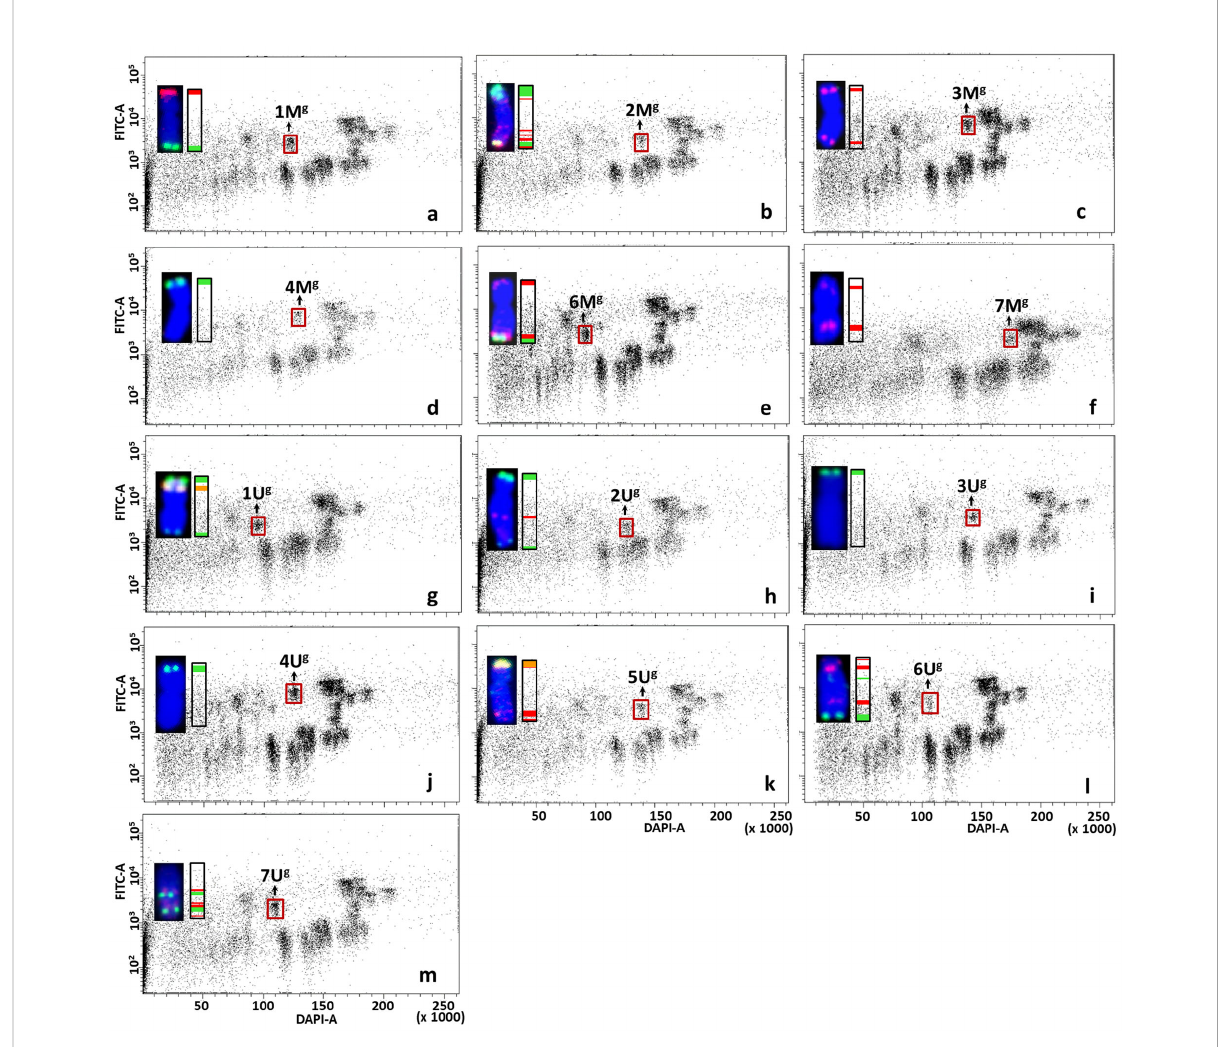
FIGURE 8 Bivariate fl ow karyotypes DAPI vs. FITC obtained after FISHIS with GAA 7 on chromosomes isolated from wheat CS- Ae. geniculata acc. TA2899 addition lines. The analysis permitted discrimination of the whole chromosome set from tetraploid Ae. geniculata (brown boxes) in the genetic background of bread wheat (A – M) . The chromosomes (inset) were sorted in high purity and identi fi ed by FISH on microscope slides with probes for Afa family repeat (red), 45S rDNA (orange) and pSc119 .2 repeat (green). Chromosomes were counterstained with DAPI (blue). x-axis, relative DAPI fl uorescence; y-axis, relative (GAA) 7 -FITC fl uorescence.